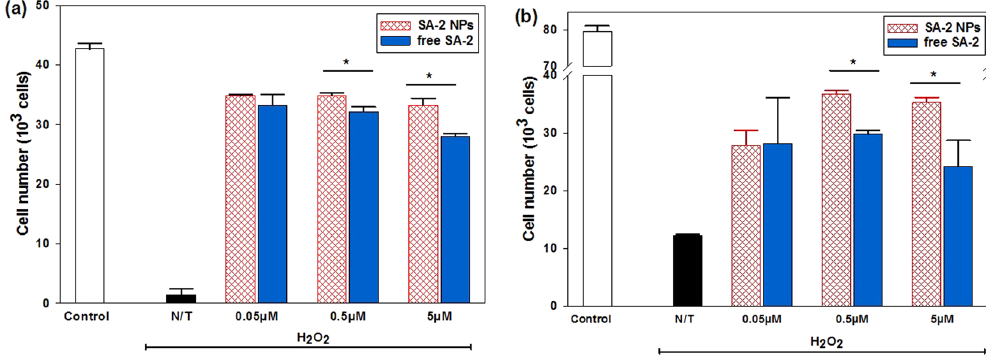
Figure 7. Effects of SA-2 NPs on HUVECs compared to that of free SA-2 under H 2 O 2 induced oxidative stress conditions after ( a) 1 day and ( b ) 4 days of treatment. Cells were seeded and allowed to attach on tissue culture plates. Cell samples were added to either SA-2 or SA-2 NPs at different concentrations, stressed with H 2 O 2 and incubated for 1 day or 4 days. Controls were cells not exposed to stress or any treatment reagent. N/T samples were cells exposed to H 2 O 2 without any test compound. Cell numbers for studied groups were analyzed on SigmaPlot with ANOVA followed by post hoc comparisons. Results are presented as mean values ± SD. Stars ( * ) indicates significant differences (P < 0.05; n = 4) with respect to free drug at the same concentration.